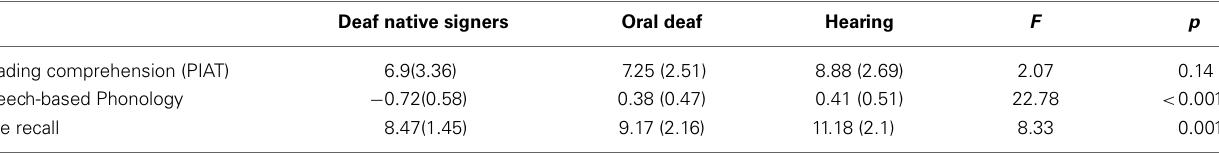
Table 2 | Group performance on behavioral